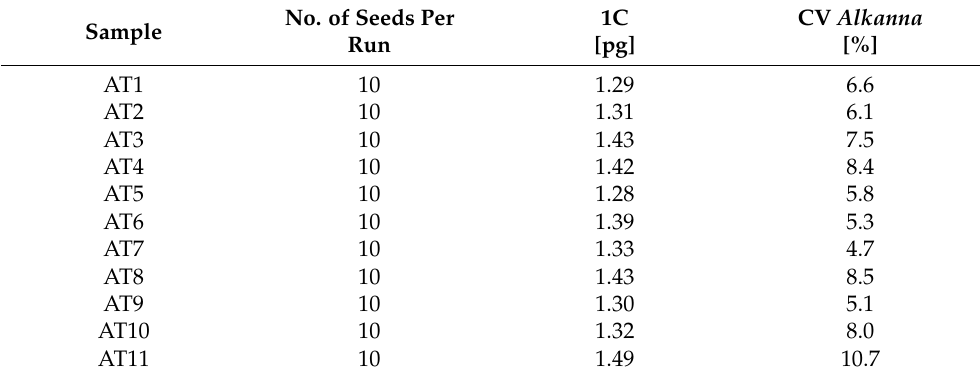
Table 5. DNA content in the seeds of the studied population of A. tinctoria